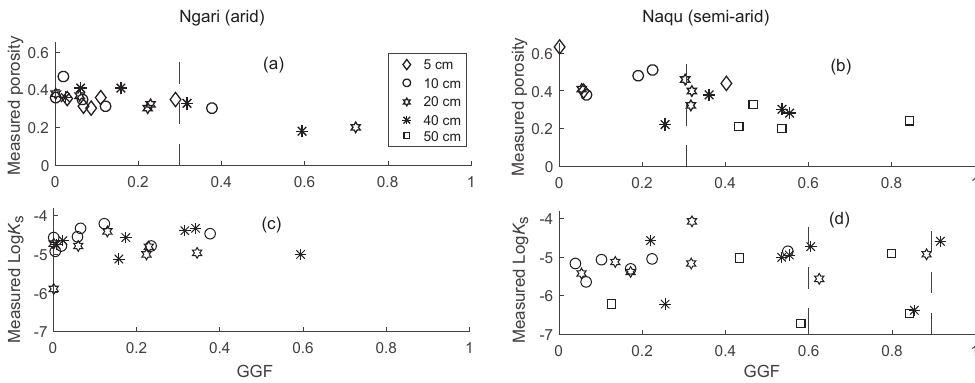
Figure 7. Scatter points of measured porosities (a, b) and K s (c, d) with GGF varying at different depths in the arid and semi-arid zones.